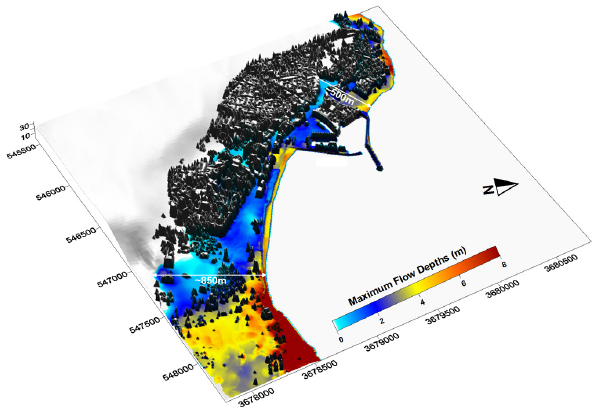
Fig. 11. Computed current velocities offshore and within the inun- dated area of El Jadida considering the M w = 8 . 5 HS